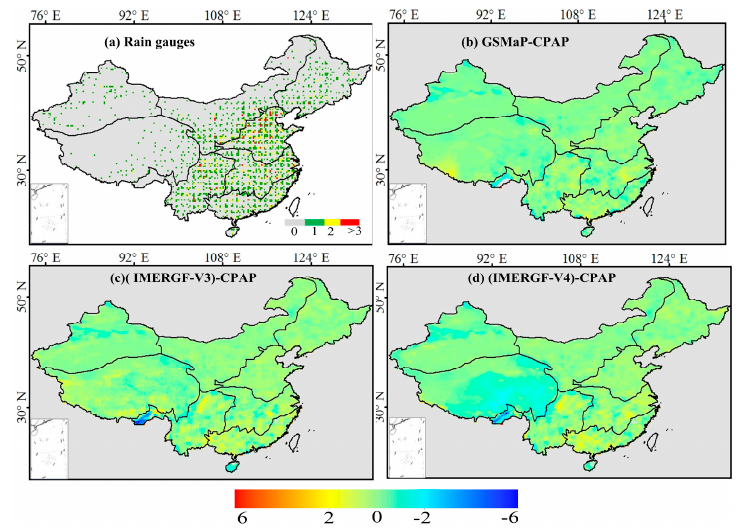
Figure 2. Spatial patterns of annual daily average difference precipitation for gauge-observed and satellite-based datasets from March 2014 to February 2015 (mm/day).